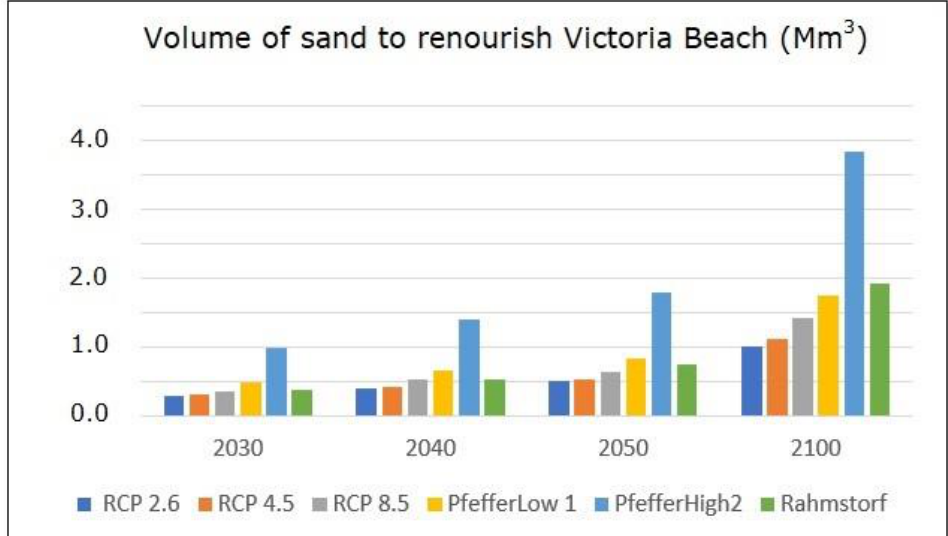
Figure 7. Volume of sand (Mm 3 ) required to renourish Victoria Beach in the projected years 2030, 2040, 2050, and 2100, according to the different models and scenarios.